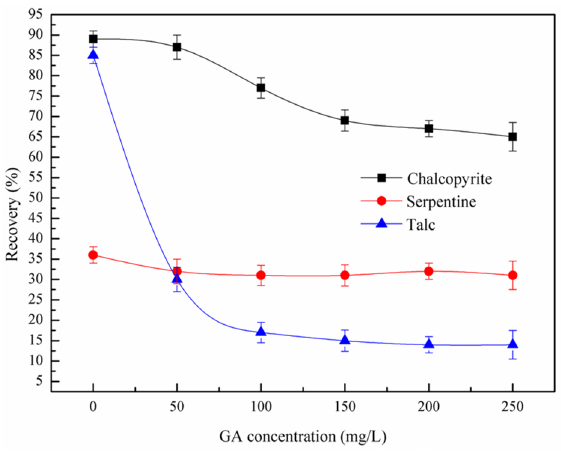
Figure 4. Effect of GA on flotation of chalcopyrite, serpentine and talc at pH = 7, c (PBX) = 80 mg/L.